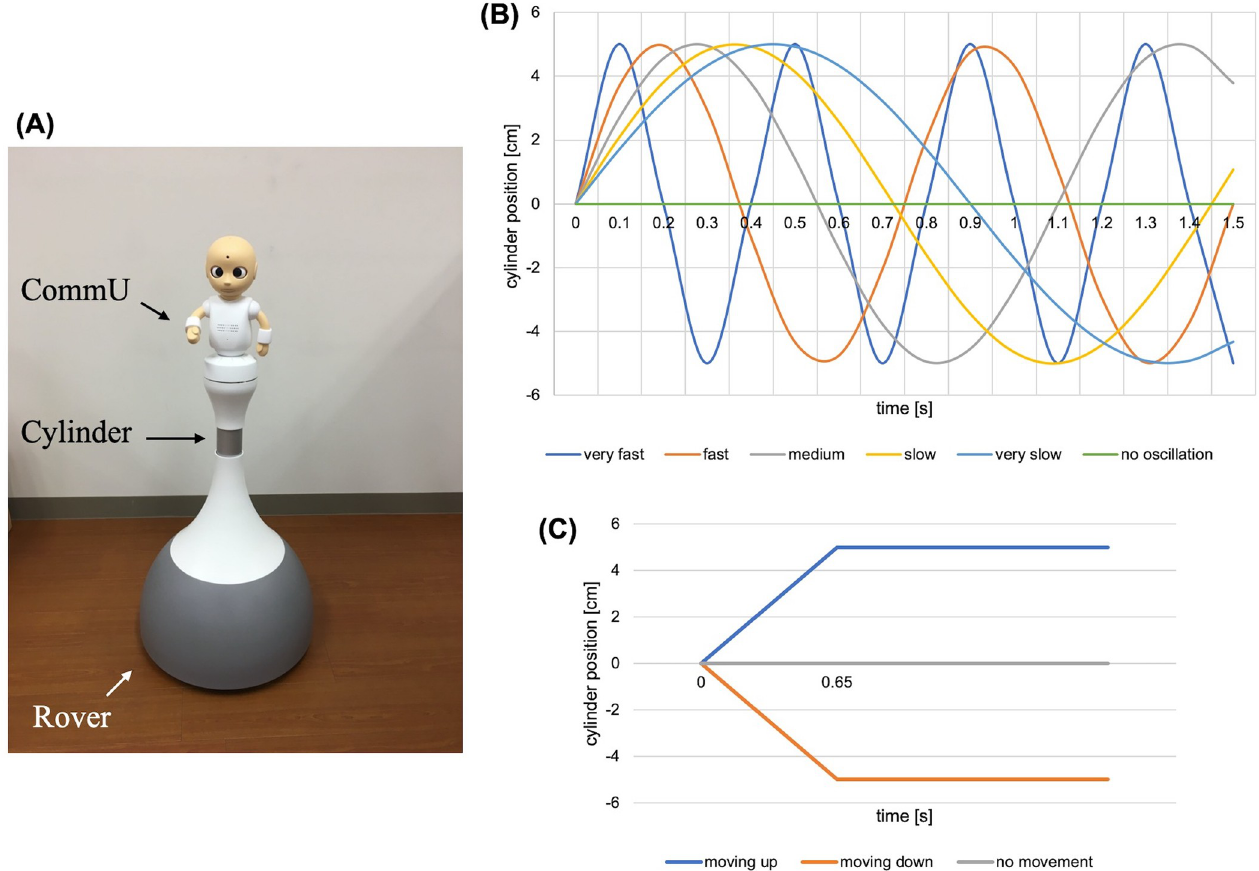
Fig 2. Robot and its vertical oscillation/transition. (A) Robot utilized in the study (Locomotive-CommU), (B) Six different oscillations designed for vertical oscillation of the cylinder of the robot, (C) Three different movements implemented for vertical transition of the cylinder of the robot. Robot vertical movements for emotion expression. The vertical movement of the robot was composed of two elements: vertical oscillation and vertical transition of the robot’s cylin- der. For the vertical oscillation, six different oscillation speeds for the cylinder including no oscillation were implemented (see Fig 2B). For the vertical transition, changing the height of the cylinder was adopted. It consisted of 3 types: moving up, moving down, and not changing the height (see Fig 2C). Then, the vertical movement of the robot was realized by combining the vertical oscillation and transition. To avoid unnatural vertical movement of the robot, when both the oscillation and transition were adopted, the robot did not start oscillating until the vertical transition was complete (see Fig 3 for examples of the movement). Note that since the utilized robot was ROS compatible including its vertical cylinder, the vertical movements were simply realized by sending the standard ROS locomotion message type, i.e., geome- try_msgs/Twist, with the signaling features shown in the figures. Robot gestures for emotion expression. In order to study the effect of a robot’s vertical movement on the improvement of its emotion expression, basic gestures expressing the robot’s emotions are required, so that the vertical movement could be added to them and the improve- ment of the expression could be studied. Note that in order to avoid complexity in the study, the utterance of the robot was not considered or utilized and left for future works, although it